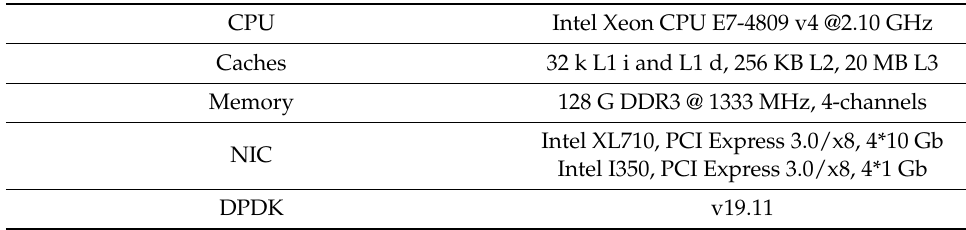
Table 4. System-under-test data